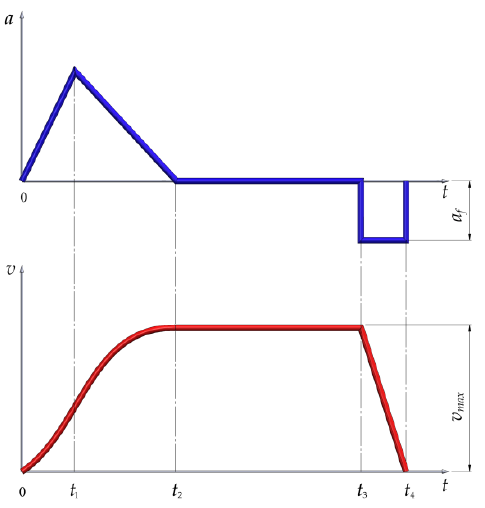
Figure 4. Variation of speed ( v ) and acceleration ( a ) for a single transport cycle.